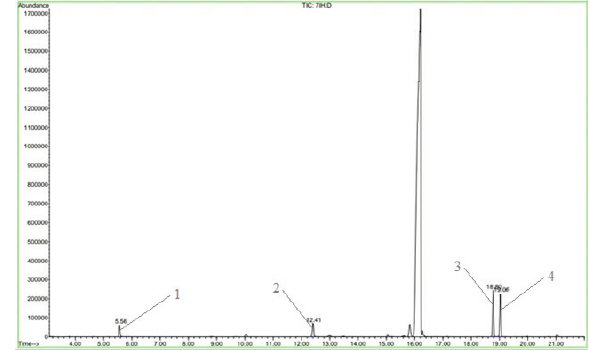
Figure 2. Chromatogram of free carbohydrates in the herbal mixture No. 3 (1 – arabinose, internal standard; 2 – glucose; 3–4 – fructose; 5 – sucrose).